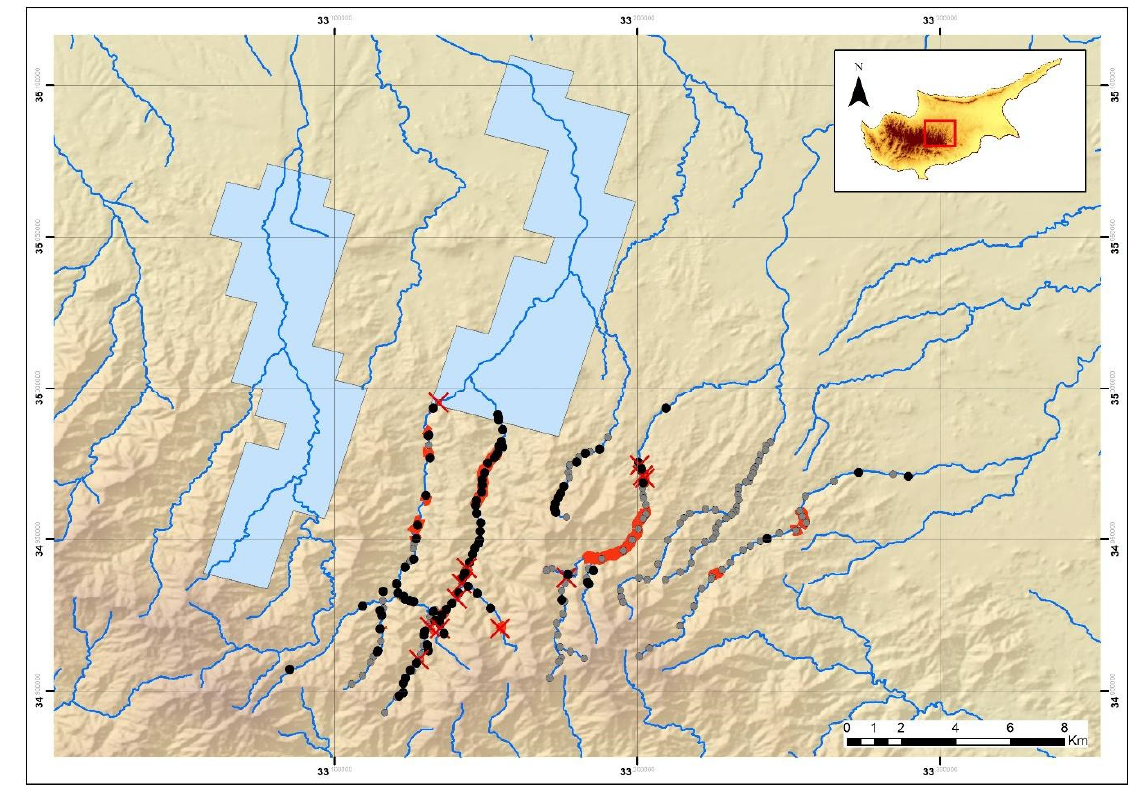
Figure 3. Map of the study area in the Troodos Mountains indicating the extent of the current survey. Blue polygon: known species distribution of N. n. cypriaca in the Troodos Mountains. Grey dots: sites not accessible or not visited due to time constraints. Black dots: visited sites for assessing habitat quality. Red X: sites qualified as “Good” candidates for the species’ presence but not visited due to time constraints. Red lines: transect lines conducted. Blue lines: main rivers and seasonal streams.